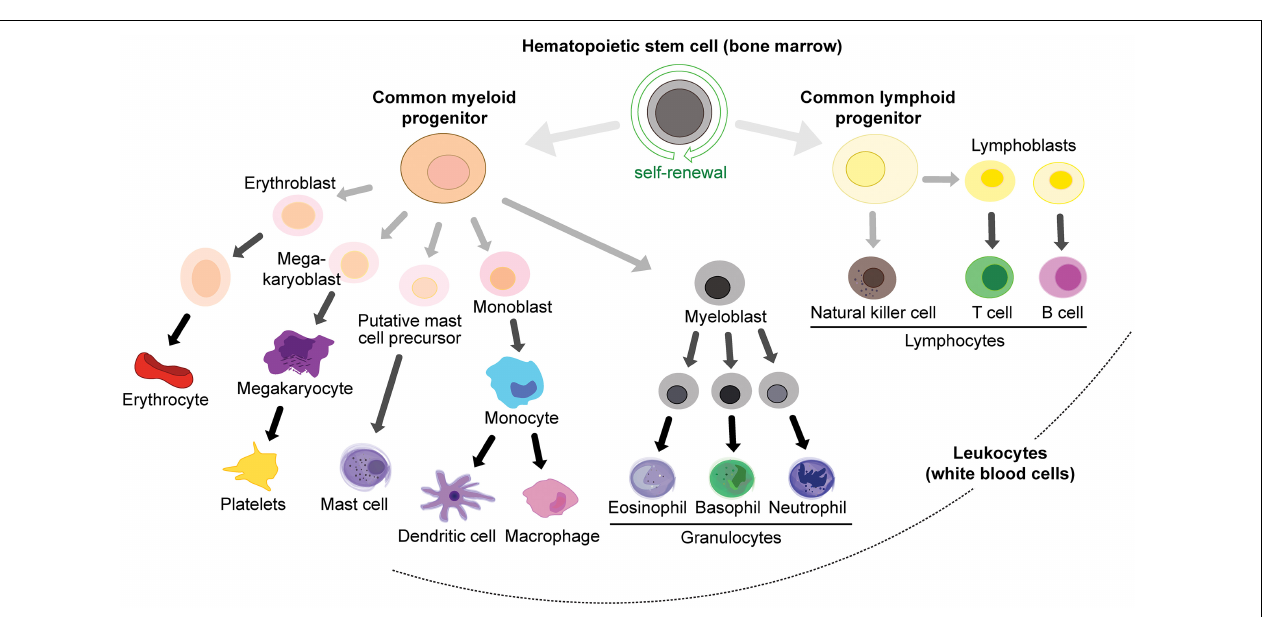
FIGURE 3 | Immune cell lineages in the